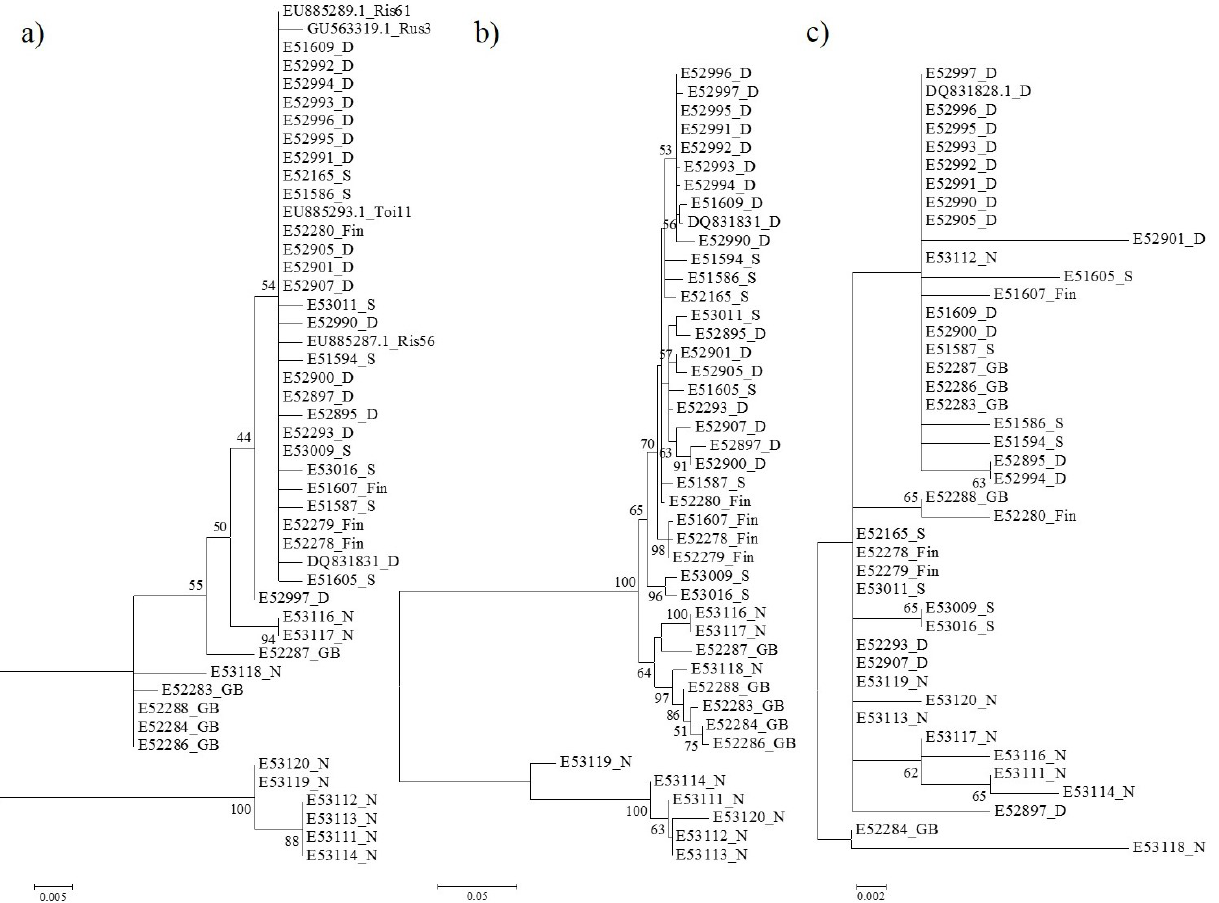
Figure 2. Phylogenetic analysis using nucleotide or amino acid sequences of RNA 3′ UTR or p3 and p4 coding region. ( a ) Phylogenetic tree of amino acid sequence analysis of the nucleocapsid protein (p3) coding region; ( b ) Phylogenetic tree of nucleotide sequence analysis of RNA3 3′ UTR; ( c ) Phylogenetic tree of amino acid sequence analysis of p4 coding region. The evolutionary history was analyzed with the maximum likelihood method based on the Kimura-2-parameter model for nucleotide sequences and the Poisson correction model for amino acid sequences, respectively. The percentage of replicated trees in which the associated taxa clustered together with 1000 replicates from bootstrapping is shown next to the branches. Bootstrap values lower than 50% were hidden. Forty-two variants from this study, the virus type isolate from Hamburg-Germany (GenBank RNA3: RNA3 sequences